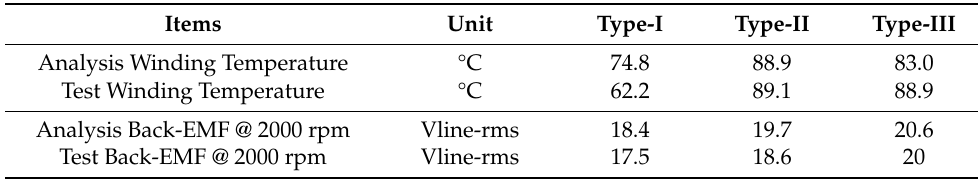
Table 8. Analysis and test results of Winding temperature and Back-EMF line voltage.